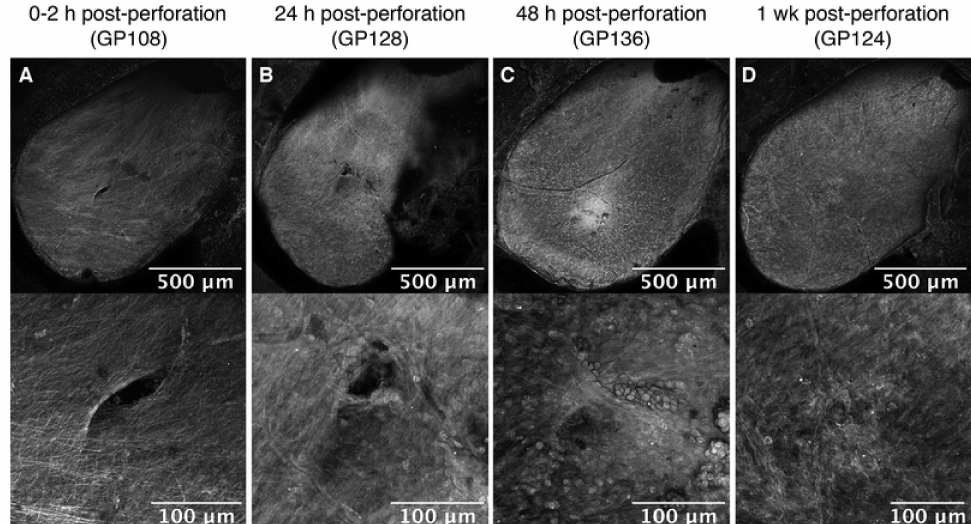
Figure 4. Guinea pig RWM healing after perforation with 100 µ m-diameter microneedle perforations under low magnification ( top ) and high magnification ( bottom ) at ( A ) 0–2 h, ( B ) 24 h, ( C ) 48 h, and ( D ) 1-week post-perforation. (Reprinted with permission from Ref. [36], 2020, Jeffrey W. Kysar, PhD and Anil K. Lalwani,